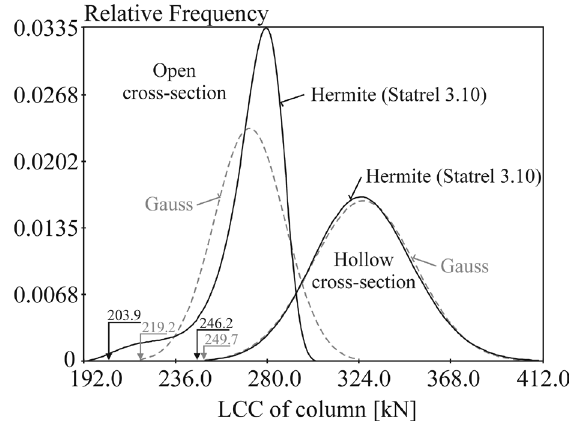
Fig. 10. LCC of columns with open and hollow